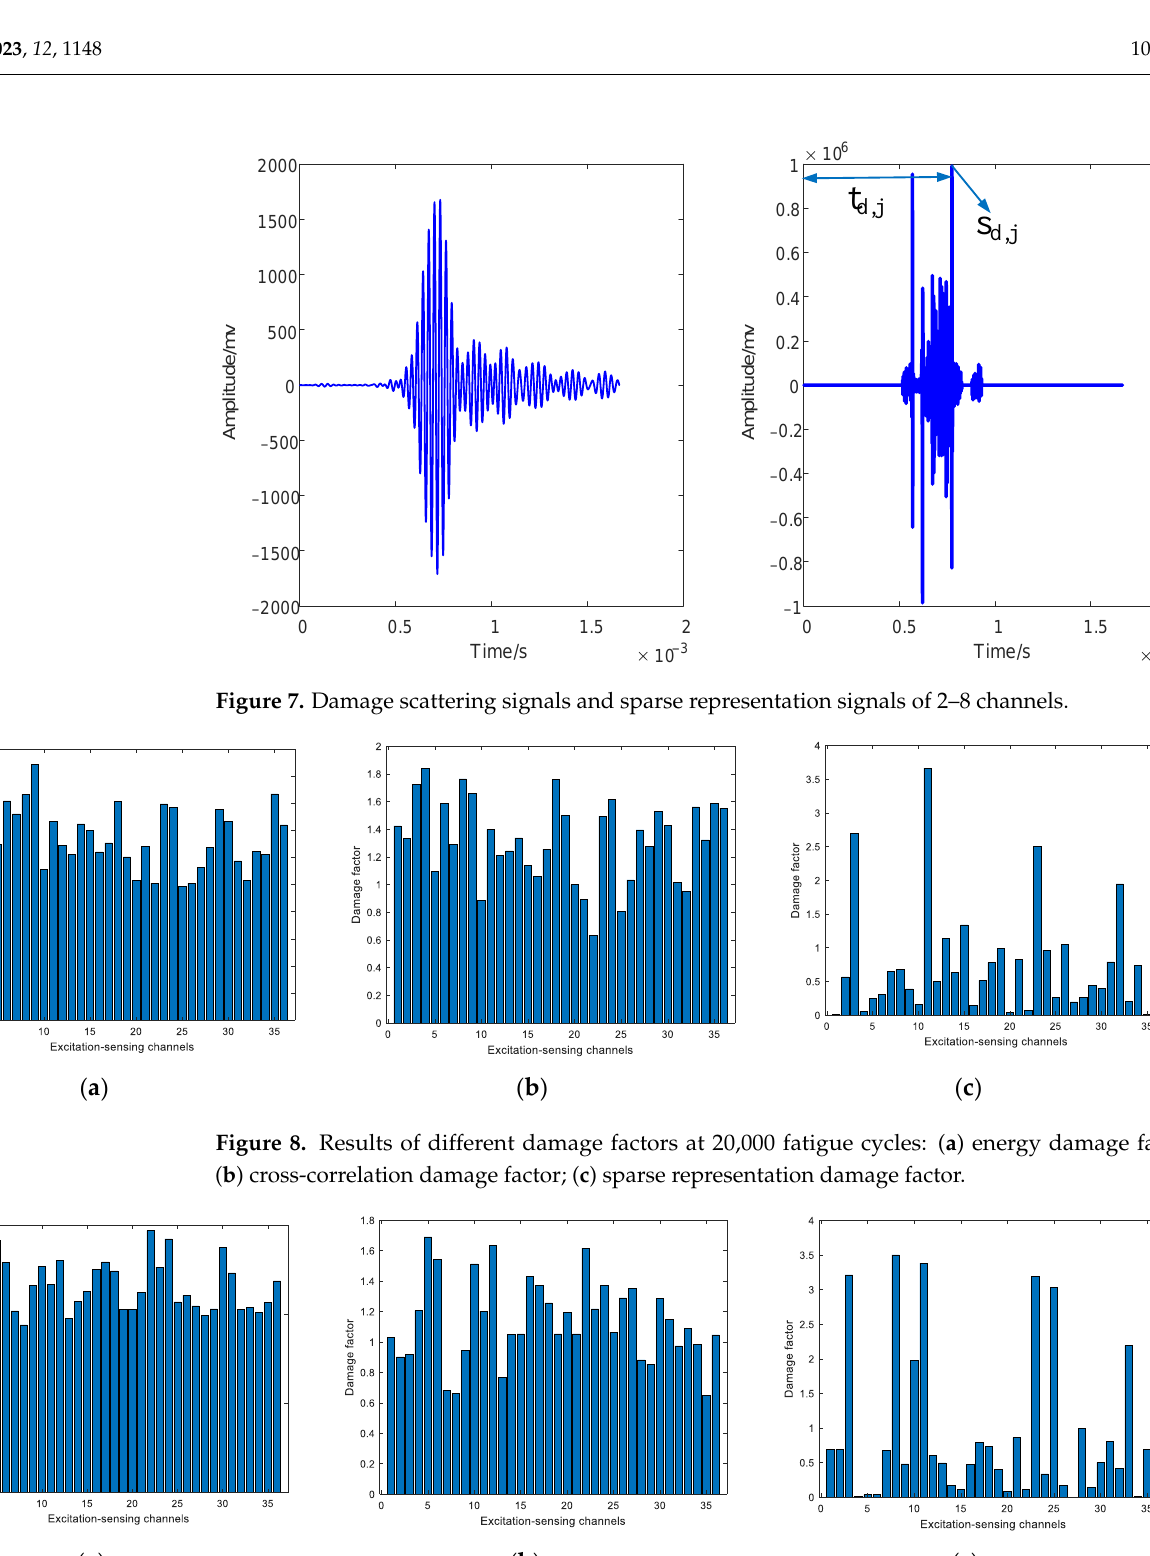
Figure 8. Results of different damage factors at 20,000 fatigue cycles: ( a ) energy damage factor; ( b ) cross-correlation damage factor; ( c ) sparse representation damage factor.